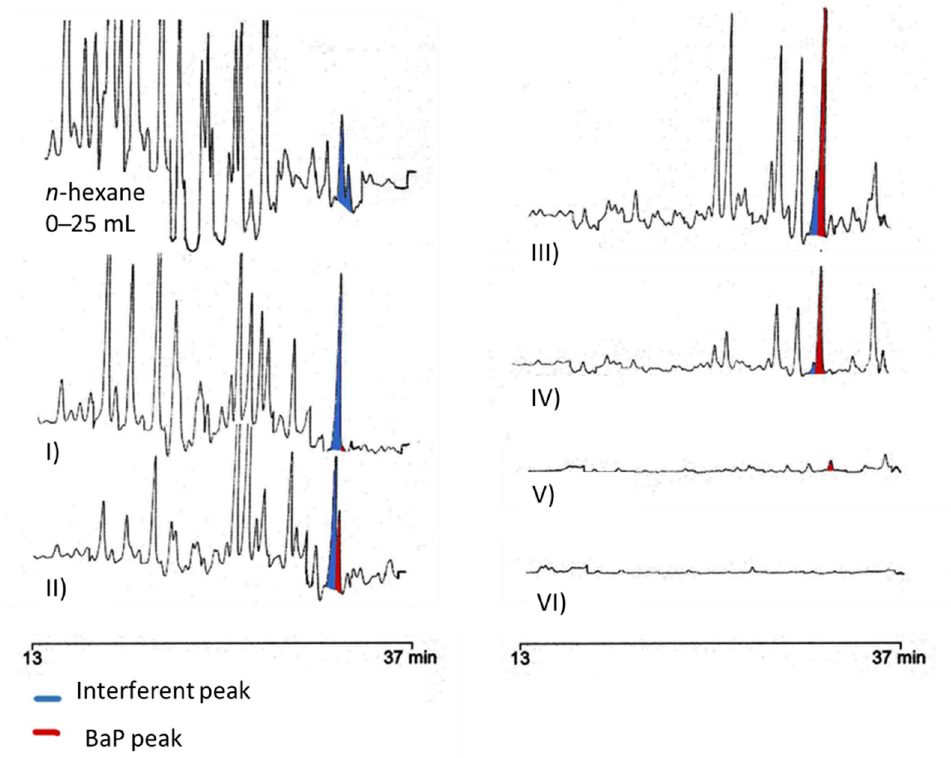
Figure 3. HPLC-FLD traces obtained by fractionation of a crude pomace oil sample on a 5 g amino SPE cartridge. Subsequent fractions, consisting of 3 mL of n -hexane/toluene (70/30, v/v ) are marked by Roman numerals (from I to VI).